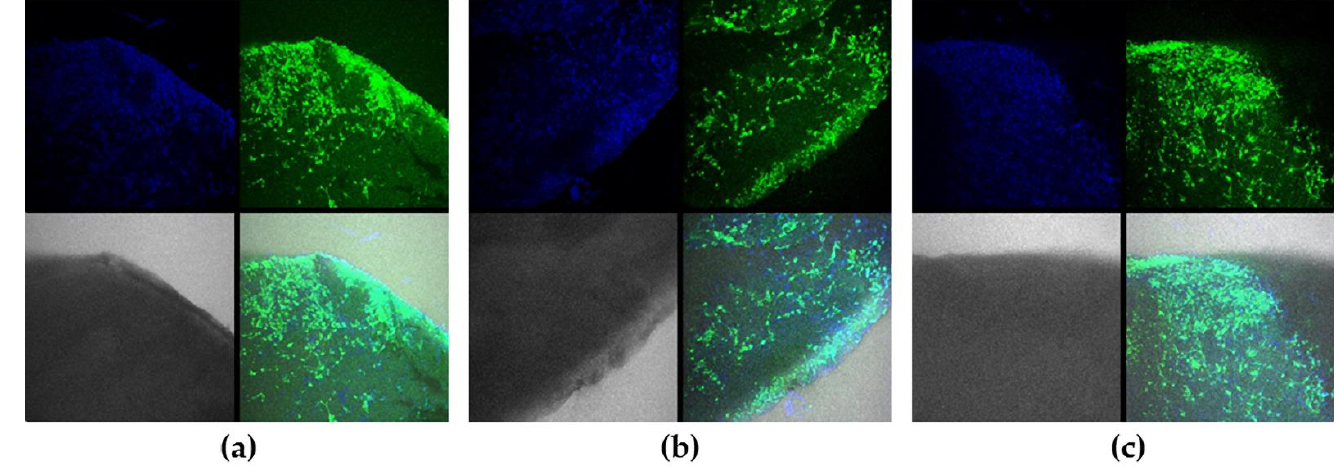
Figure 12. Confocal images of ELS COL ( a ), ELS COL 0.1% ( b ), and ELS COL 1% ( c ) scaffolds cultured with Bj-5ta fibroblasts, 8 days of incubation. Green is for calcein AM staining (live cells), blue is for Hoechst 33342 staining (cell